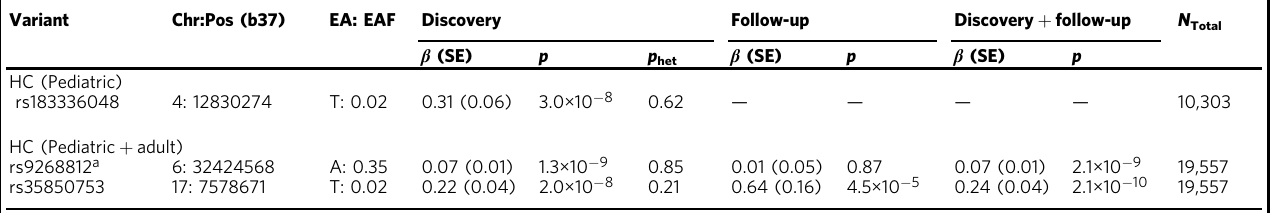
Table 1 Novel loci for fi nal head circumference Variant